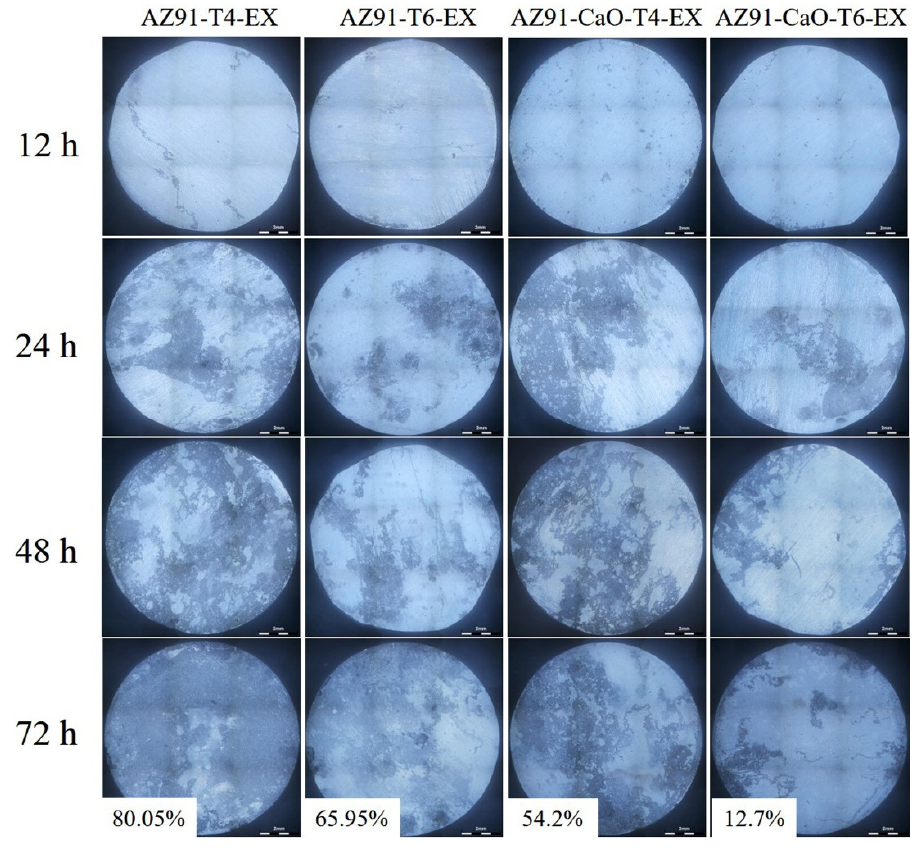
Figure 8. Salt spray corrosion morphologies of extruded AZ91 and AZ91-CaO alloys at different times and states.